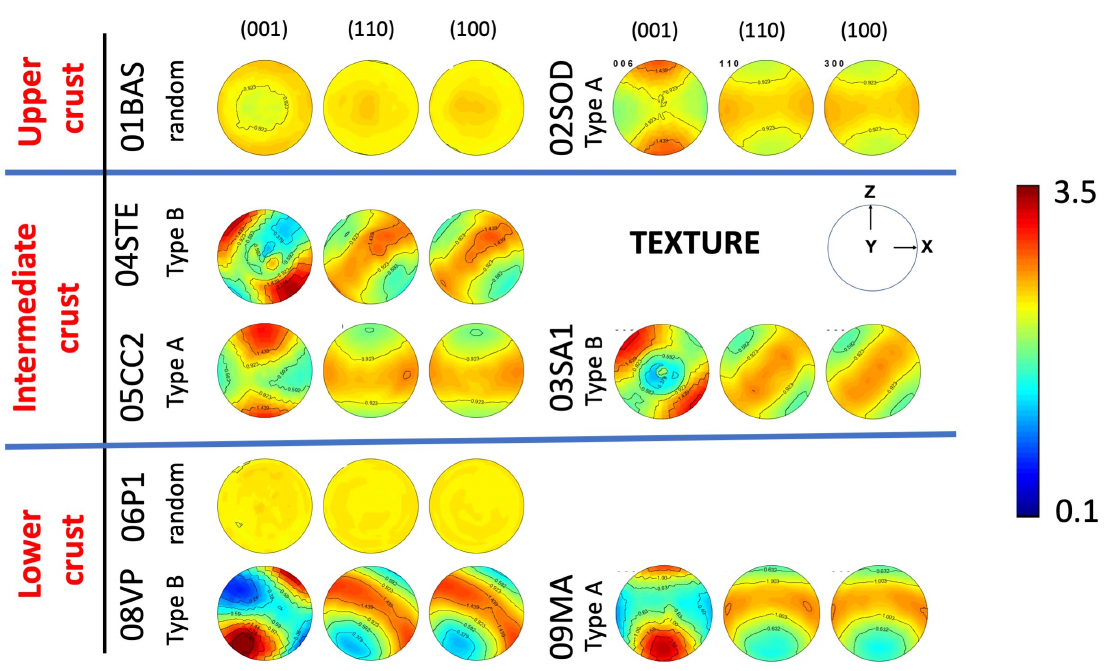
Figure 5. Texture of the studied sample. Pole figures represent density contours of poles to plane (001), (110), (100), in multiple of uniform distribution (mud). Axes reference as in Figure 3b.